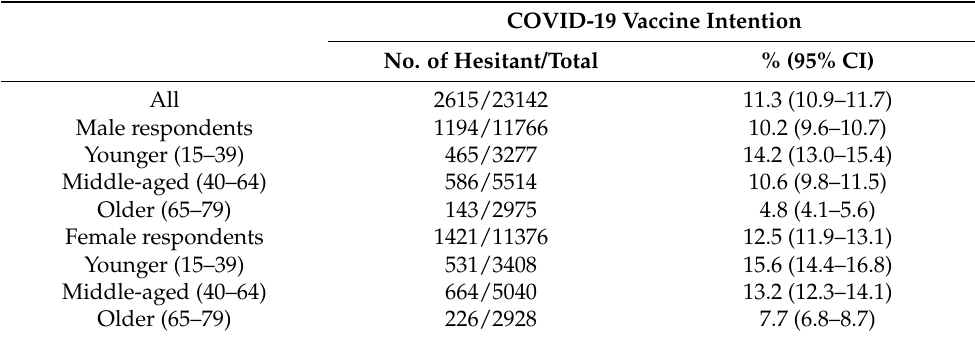
Table 2. Proportion of COVID-19 vaccine hesitancy, stratified by age and sex.